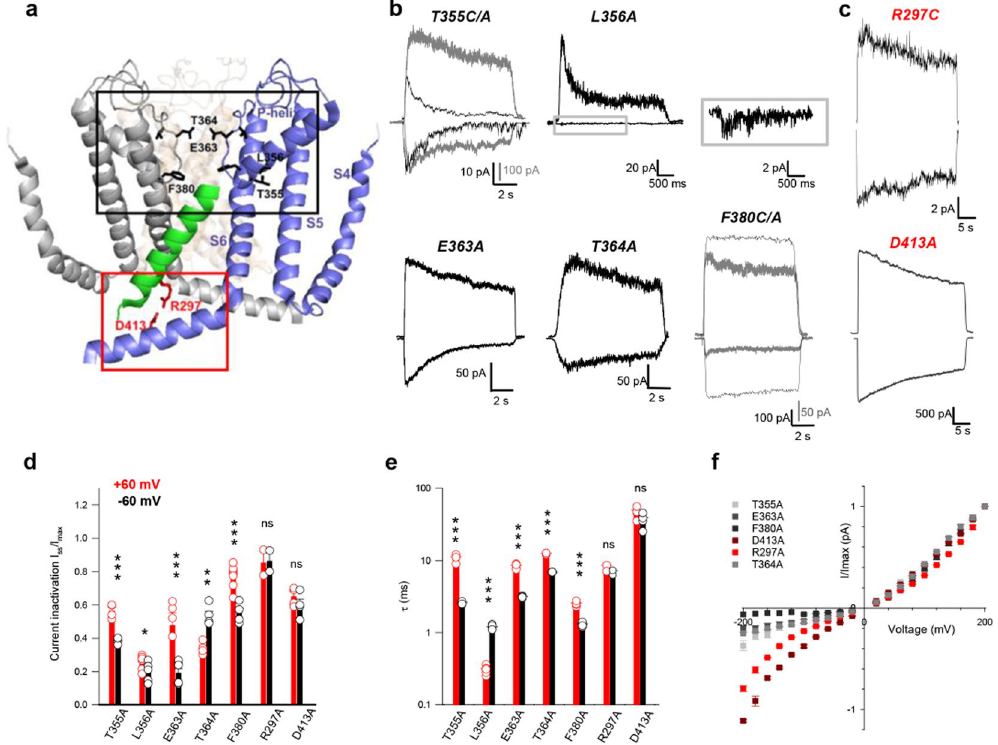
Figure 1. Inactivation of mutant channels. ( a ) Mapping CNGA1 residues on the TAX-4 structure (PDB ID: 5H3O): in grey and blue S4-S6, P-loop and C-linker regions of two opposite TAX-4 monomers; in green partial S5 region (S302-V317) of a third monomer. Key residues are in stick representation. Mutant channels that inactivate in a voltage dependent manner (black square); mutant channels that inactivate in a non-voltage dependent manner (red square). ( b , c ) Current recordings evoked by 1 mM cGMP, during voltage steps at ± 60 mV in symmetrical Na + solution for mutant channels that inactivate in a voltage dependent manner ( b ) or that inactivate marginally ( c ). In panel (b) gray traces refer to T355A and F380A, respectively; trace at − 60 mV for mutant channel L356A is enlarged in the grey box. ( d ) Decline of cGMP-activated current for inactivating mutant channels at ± 60 mV. Histograms summarize the average ± s.e.m. and circles indicate data from single experiments at + 60 (in red) and − 60mV (in black). I ss / I max where I max is the current amplitude immediately after the application of 1 mM cGMP and I ss is the current at the steady state. ( e ) The time course of inactivation at + 60 and − 60 mV obtained by fitting with a single exponential ( d ). ( f ) Macroscopic I–V relationships obtained from current recordings as in Figure S2a scaled to the I flowing at + 200 mV. Grey scale colors were used for mutant channels that inactivate in a voltage dependent manner and red scale colors for mutant channels that inactivate in a non-voltage dependent manner; R297A (n = 2), T355A ( = 10), L356A (n = 6), E363A (n = 11), T364A (n = 4), F380A (n = 5) and D413A (n = 4). Values represent average ± s.e.m. Unpaired two–tail T-test for T355A, L356A, E363A, T364A, F380A in d: t 6 = − 7,911, P < 0.001; t 10 = − 2,274; P < 0.05; t 8 = 6,881, P < 0.001; t 6 = − 5,541; P < 0.01; t 10 = 5,652; P < 0.001. Unpaired two–tail T-test for T355A, L356A, E363A, T364A, F380A in e: t 6 = 12.981, P < 0.001; t 6 = − 24,02; P < 0.001; t 8 = 19,01, P < 0.001; t 6 = 41,021; P < 0.001; t 10 = 14,985; P < 0.001. Further statistical tests for these mutant channels and for all other tested mutants are reported in Supplementary Table 2a,b. ns = not statistically significant (P > 0.05). (n.a.) represents mutant channels with experiments not available, (f.r.) represents mutant channels with no experiments due to fast and complete rundown of the current, (n.e.) represents mutant channels with no experiments because they did not